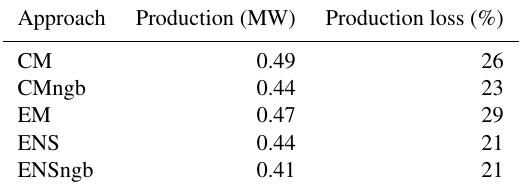
Table 2. RMSE of the different approaches for production and for production loss forecasts averaged over the three sites with produc- tion data. The production is calculated for a 2MW